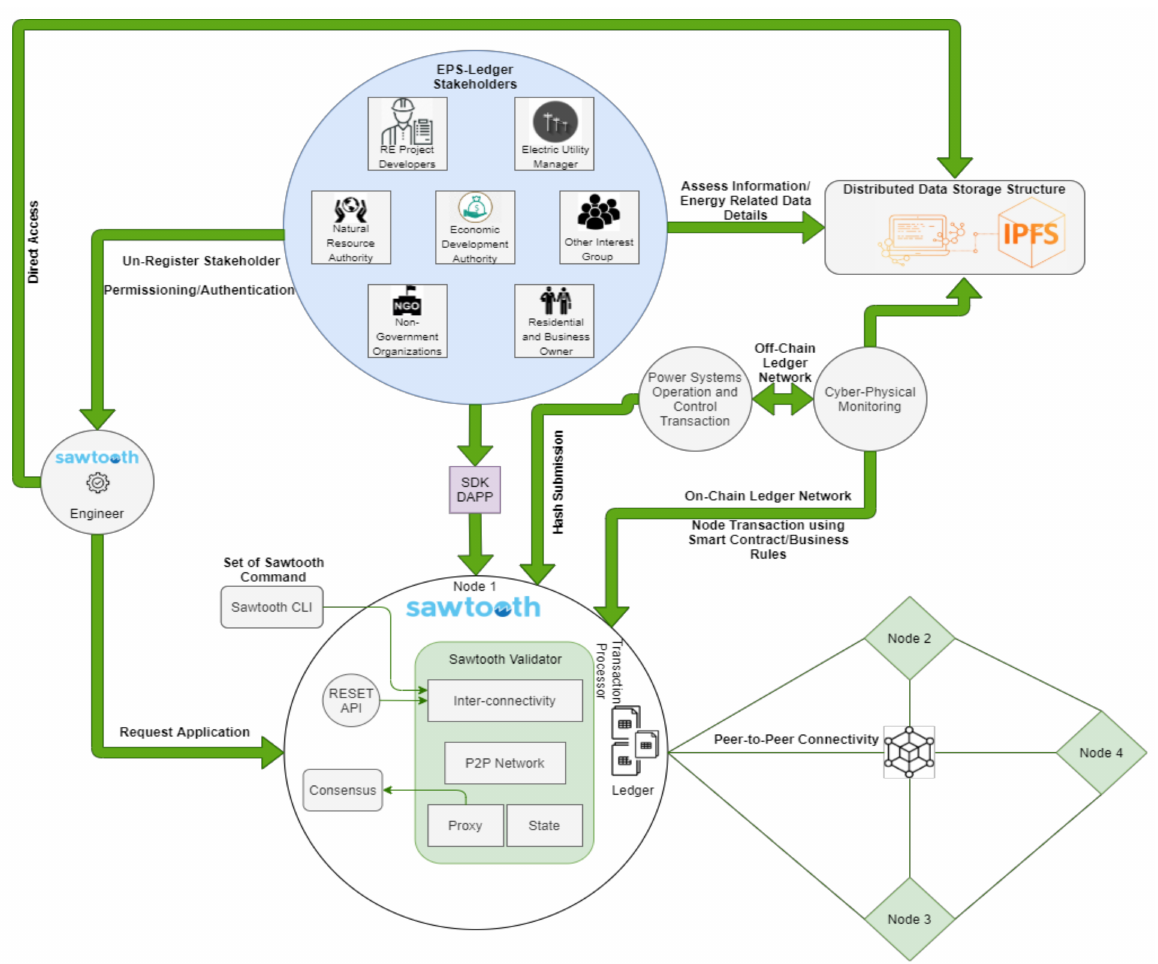
Figure 4. The proposed blockchain Hyperledger Sawtooth enables novel and secure architecture for distributed power systems control node